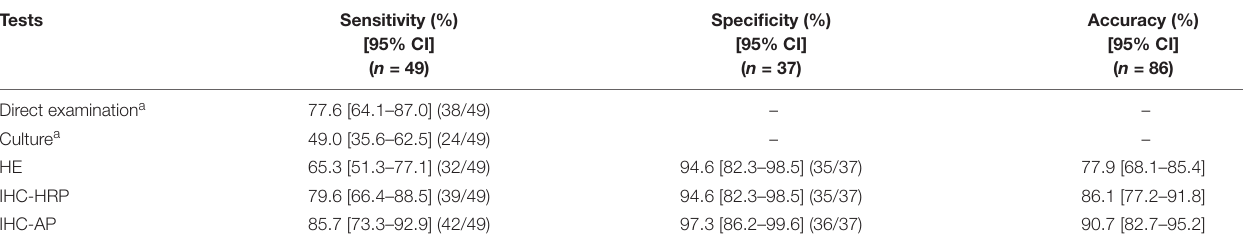
TABLE 1 | Sensitivity, specificity, and diagnostic accuracy of direct examination, culture, histopathology (HE), and immunohistochemistry (IHC) using two detection systems.